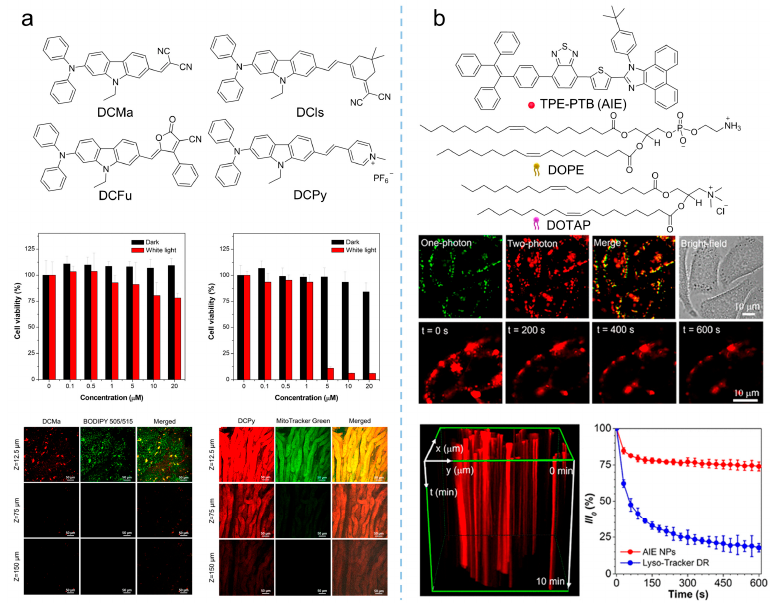
Figure 14. Multiphoton NIR absorption to enhance PDT theranostics. ( a ) Synthetic routes to DCMa, DCIs, DCFu, and DCPy and the in-vivo application of photosensitizers on the hepatic and nephric tissue of mice upon a 900 nm two-photon irradiation. Reprinted with the permission of the authors of [76]. Copyright 2018, American Chemical Society. ( b ) Molecular structure of TPE-PTB NPs, and cell imaging and photostability of AIE nanoparticles in A375 cells under continuous two-photon